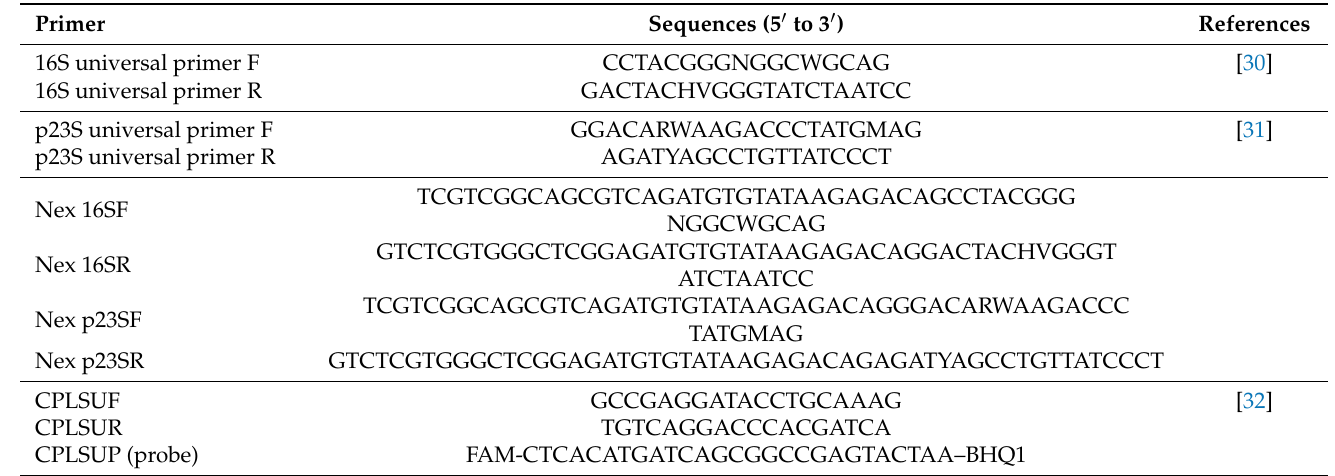
Table 1. Primer list for qPCR and metabarcoding